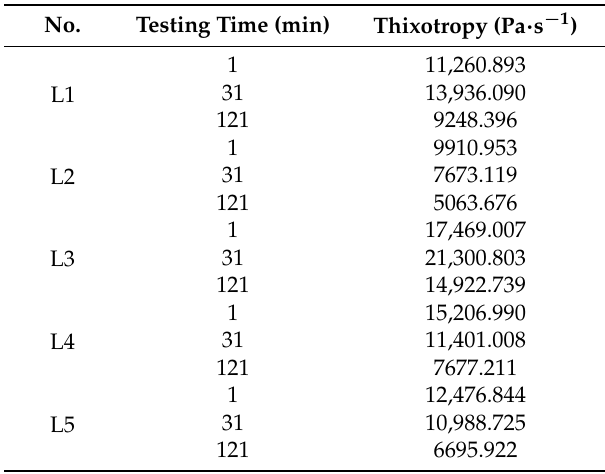
Table 7. Thixotropy of the slurry.